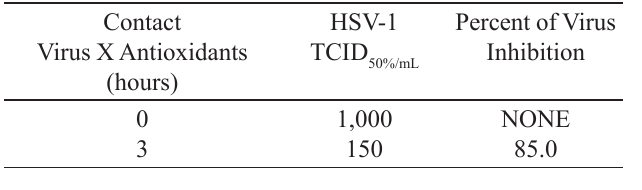
TABLE III – Inhibitory action of natural antioxidant from rosemary ( Rosmarinus officinalis, L .) 300 ppm on attachment